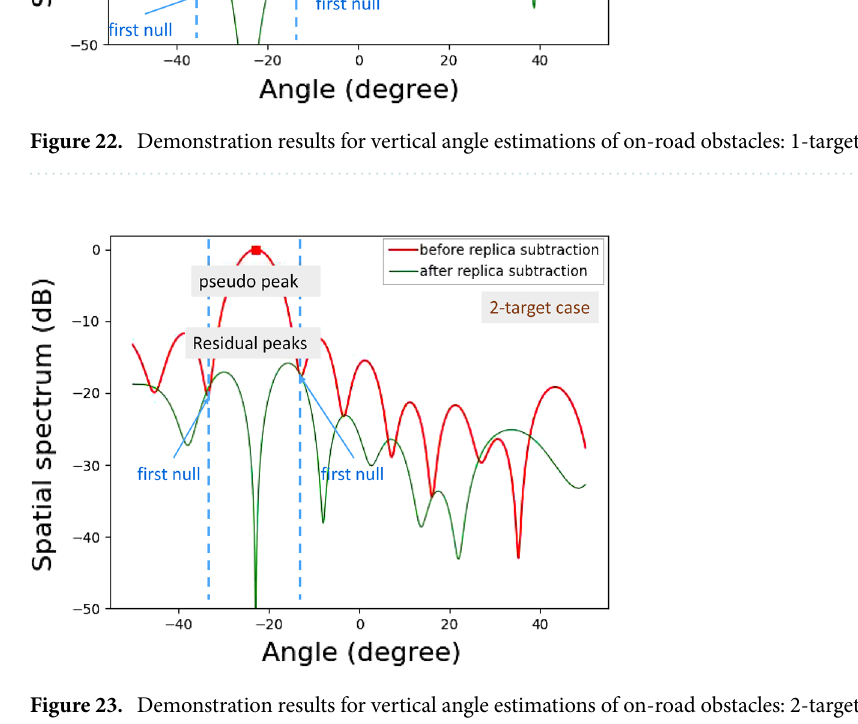
Figure 23. Demonstration results for vertical angle estimations of on-road obstacles: 2-target case.